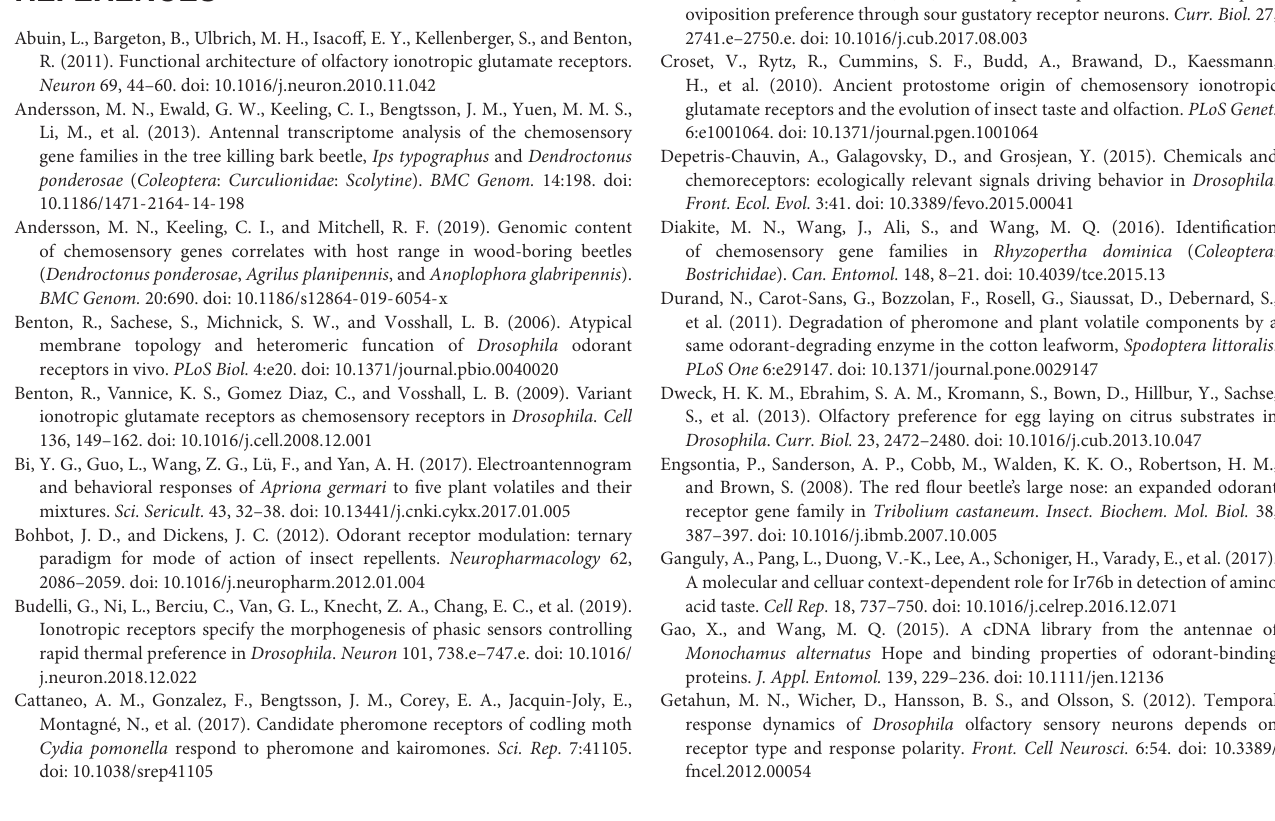
data were analyzed by least significant difference test after one-way analysis of variance. FIGURE S3 | Relative mRNA expression of AgerIRs in Apriona germari tissues. The relative mRNA levels were normalized to those of the actin gene and analyzed using the Q-gene method. All values are shown as mean ± SEM normalized. The data were analyzed by least significant difference test after one-way analysis of variance. FIGURE S4 | Multiple sequence alignment of Megacyllene caryae and Apriona germari ORs. The multiple alignment and the homology of each OR were calculated using ClustalW2 (http://www.ebi.ac.uk/Tools/msa/clustalw2/). FIGURE S5 | Sequence alignment of McarOR3 and AgerOR3. The multiple alignment and the homology of each OR were calculated using ClustalW2 (http://www.ebi.ac.uk/Tools/msa/clustalw2/). FIGURE S6 | Sequence alignment of McarOR5 and AgerOR5. The multiple alignment and the homology of each OR were calculated using ClustalW2 (http://www.ebi.ac.uk/Tools/msa/clustalw2/). FIGURE S7 | Alignment of four known Orcos and a new Orco (AgerOR25) of Apriona germari identified in this study. Malter, M. alternates ; Mcar, M. caryae ; TABLE S1 | Primers of Apriona germari olfactory receptor genes used for quantitative real-time polymerase chain reaction. TABLE S2 | Gene Ontology classification count of Apriona germari antennae